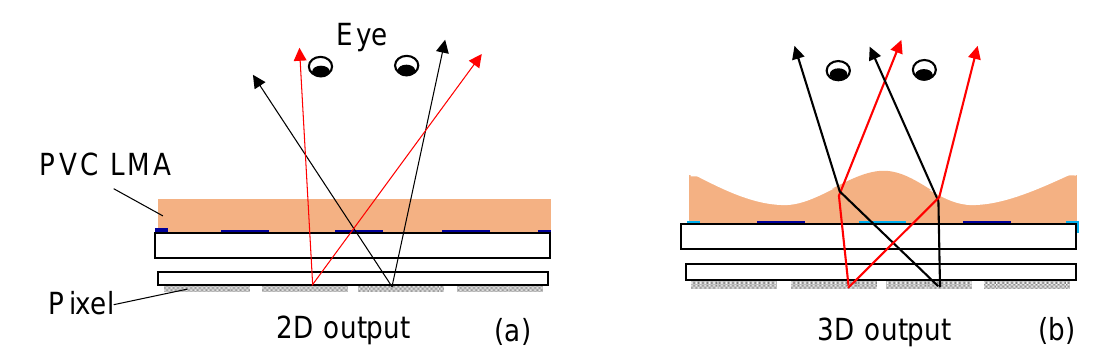
Figure 13. A PVC gel LMA used for 2D ( a ) and 3D ( b ) displays.